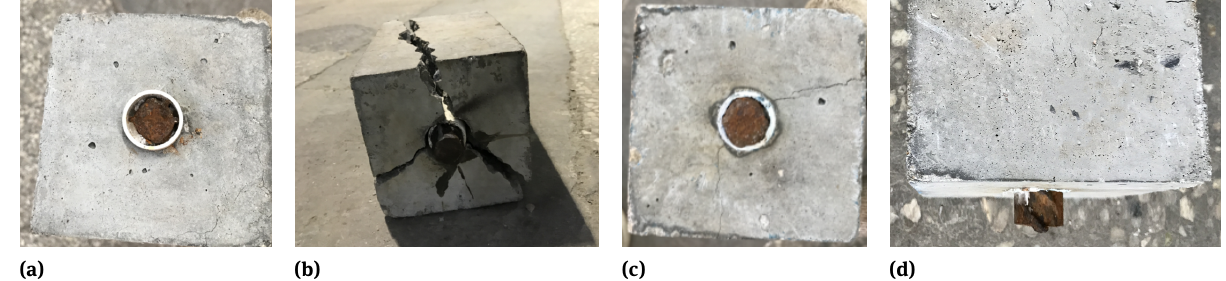
Figure 1: Failure modes of RAC specimens: (a) Pullout failure; (b) Splitting failure; (c) Pullout-splitting failure; (d) Rebar yielding failure.